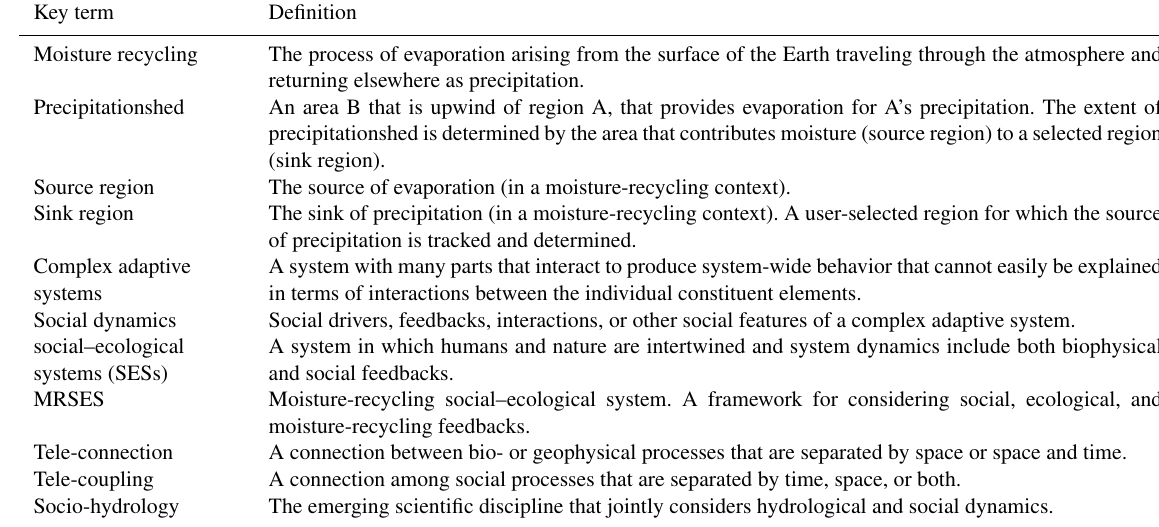
Table 1. Definitions of key terms used in this